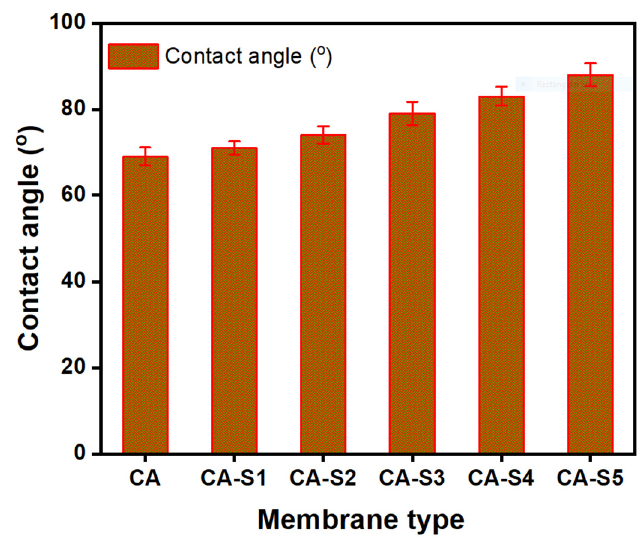
Figure 7. Contact angle of the membrane at ambient temperature.